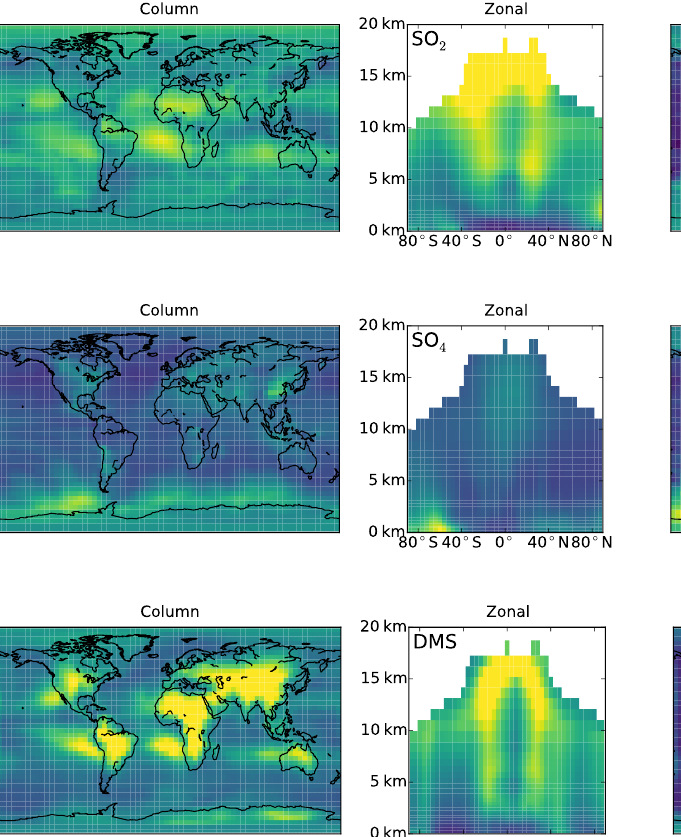
, DMS (dimethyl sulfide) and NH + from the addition 4 4